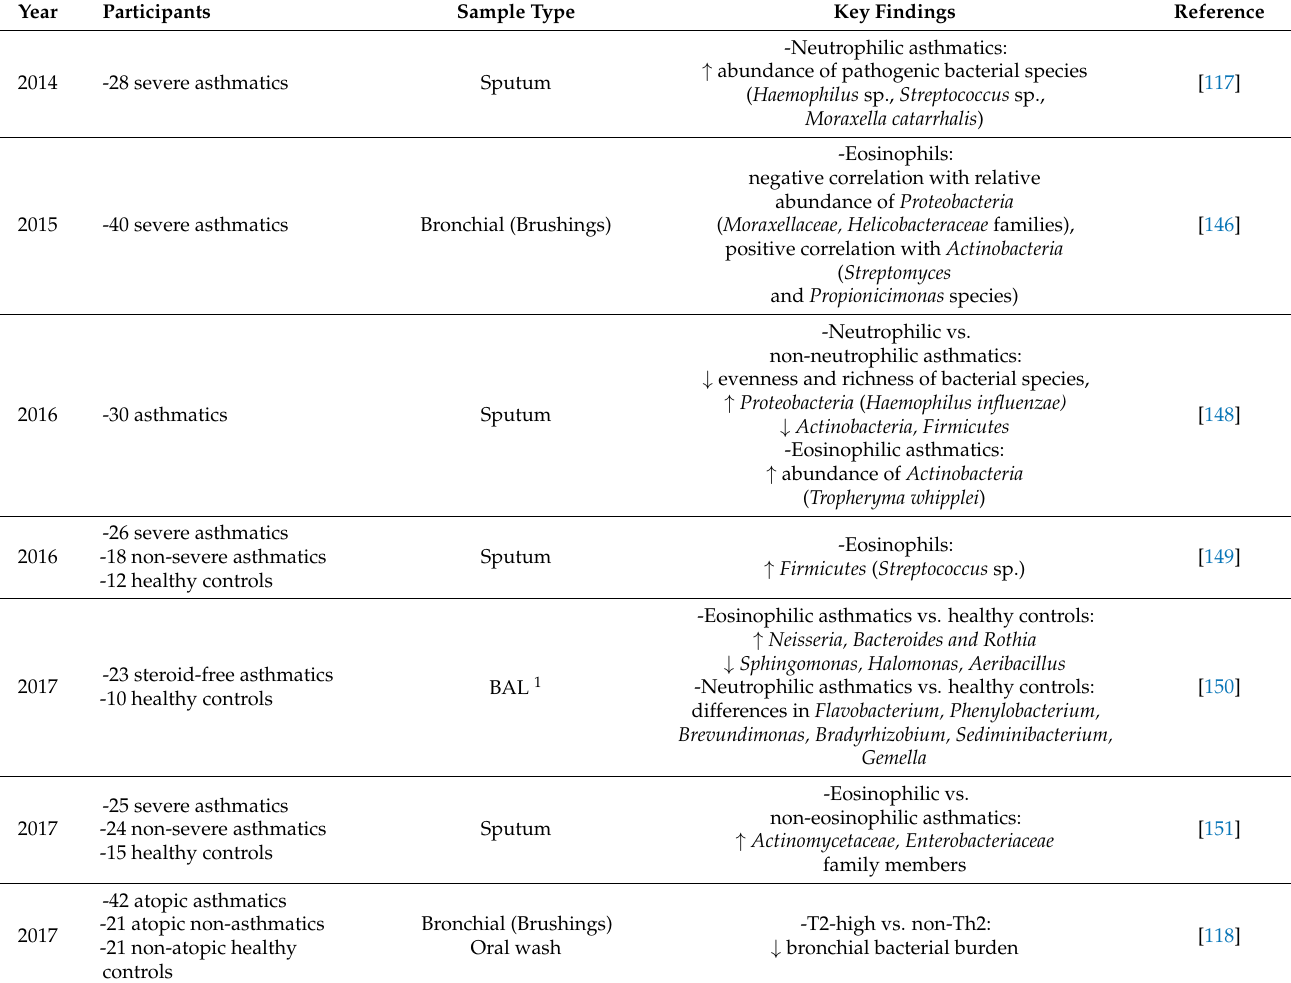
Table 1. Overview of studies analyzing the airway bacterial microbiome association to asthma inflammatory